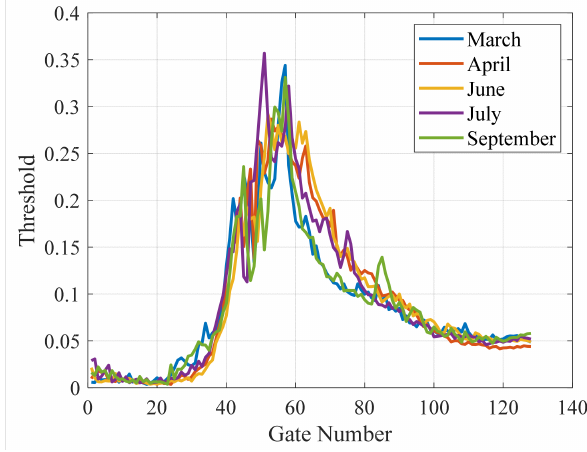
Figure 6. Adaptive thresholds of experimental area 1 for different months and different gates.